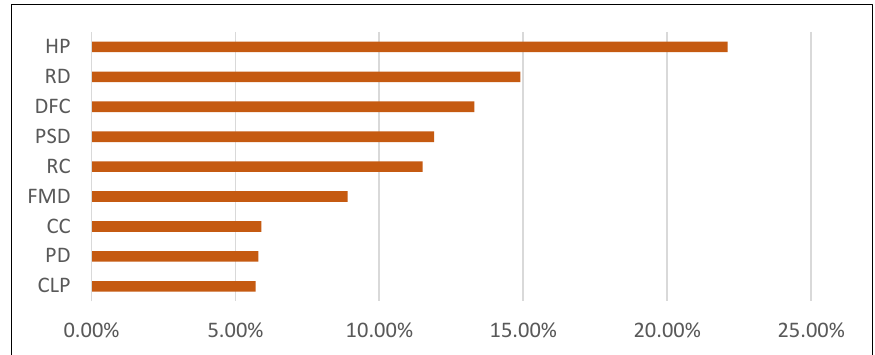
Figure 7. Significance of the influencing factor.